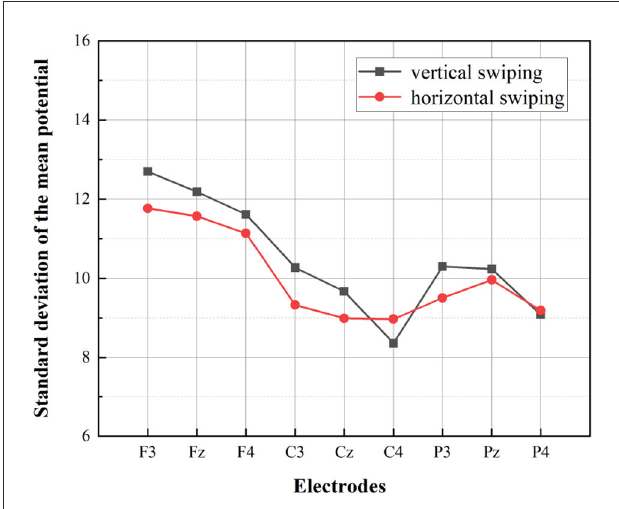
FIGURE11 Comparison of the fixation duration averaged across participants. Error bars show the standard deviation values.